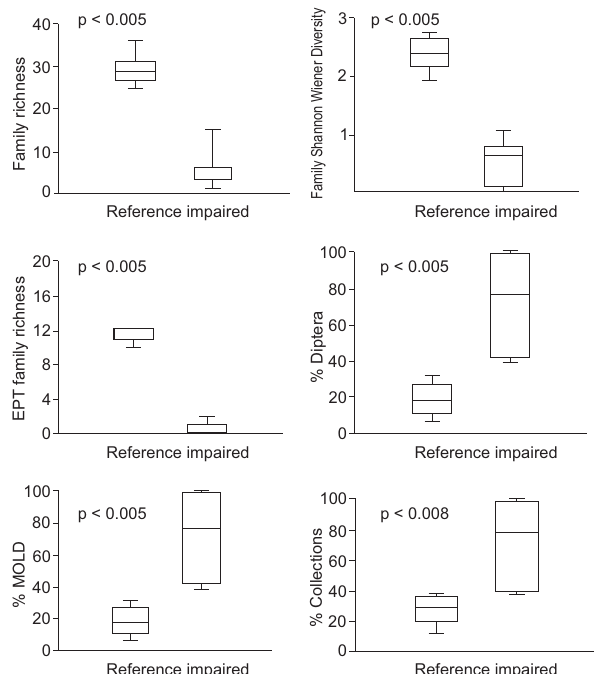
Figure 2. Comparison of distributions of each metric composing the PPPMI index. In the Box-&-Whisker plots, center lines repre- sent the median, boxes represent the first and third quartiles, and bars represent the maximum and minimum. P-values were ob- tained using Mann-Whitney U tests.